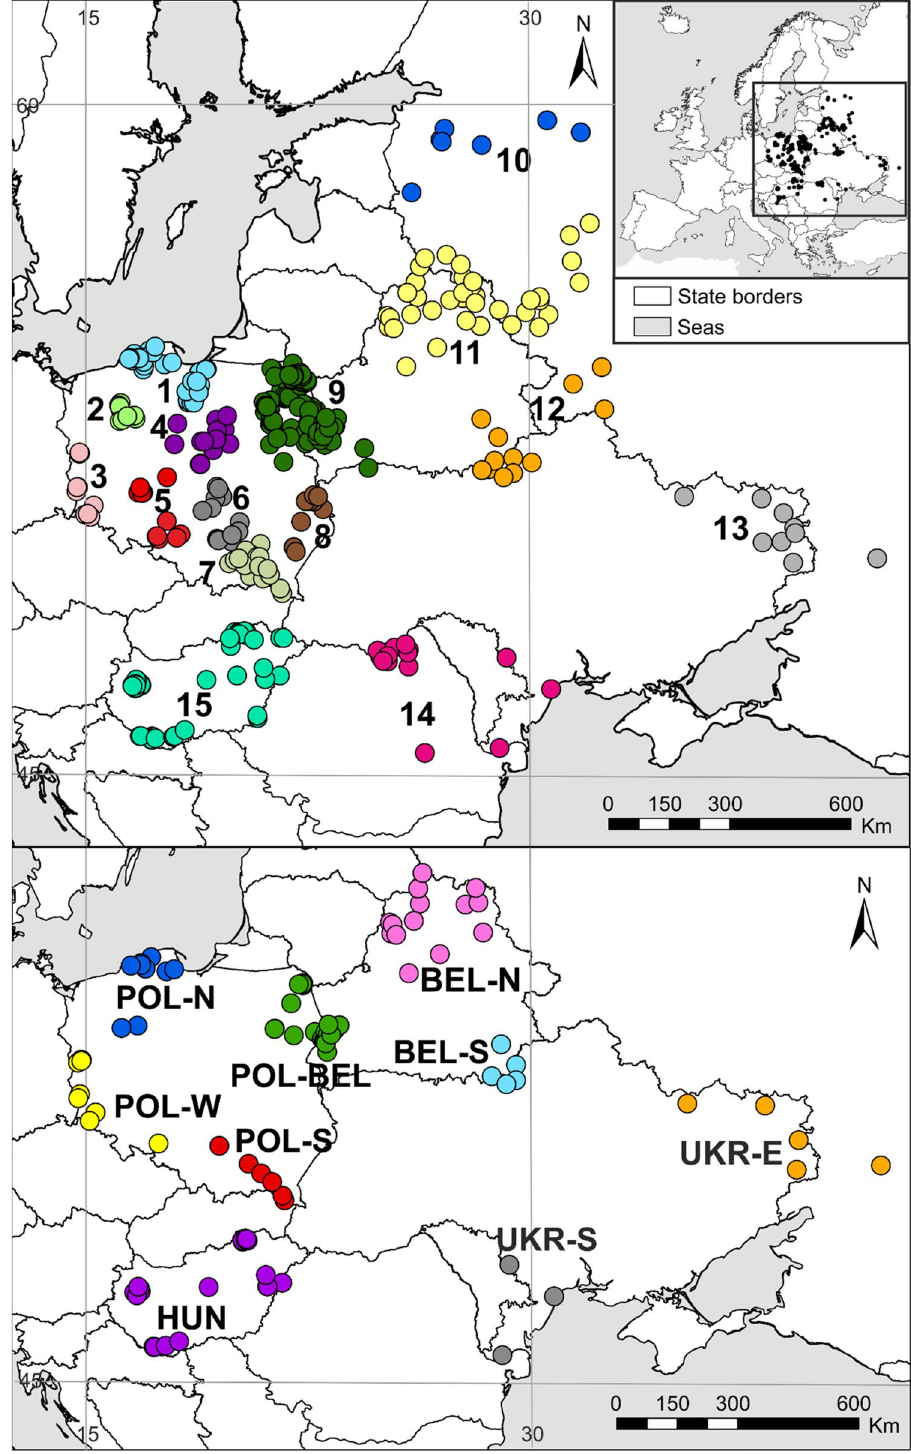
Figure 1. Distribution of wild boar ( Sus scrofa ) samples analysed in this study and grouped into 15 populations for D-loop (control region) analyses (upper panel) and 9 populations for the mitogenome-based analyses (lower panel). The map was created with the ArcGIS software 10.3.1. based on source map from ESRI https:// www. esri. com/ en- us/